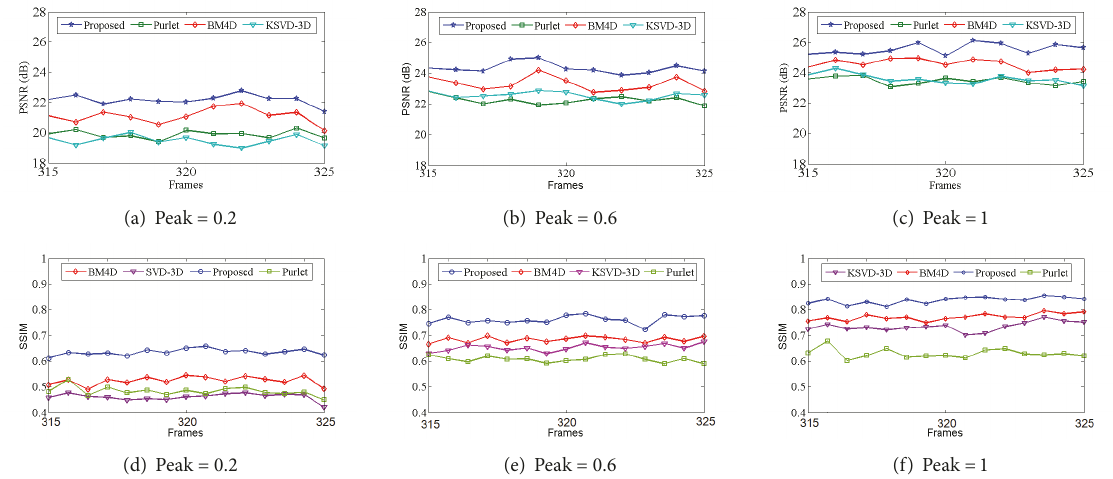
Figure 5: (a)–(c) PSNR graphs for peaks 0.2, 0.6, and 1; (d)–(f) SSIM graphs for peaks 0.2, 0.6, and